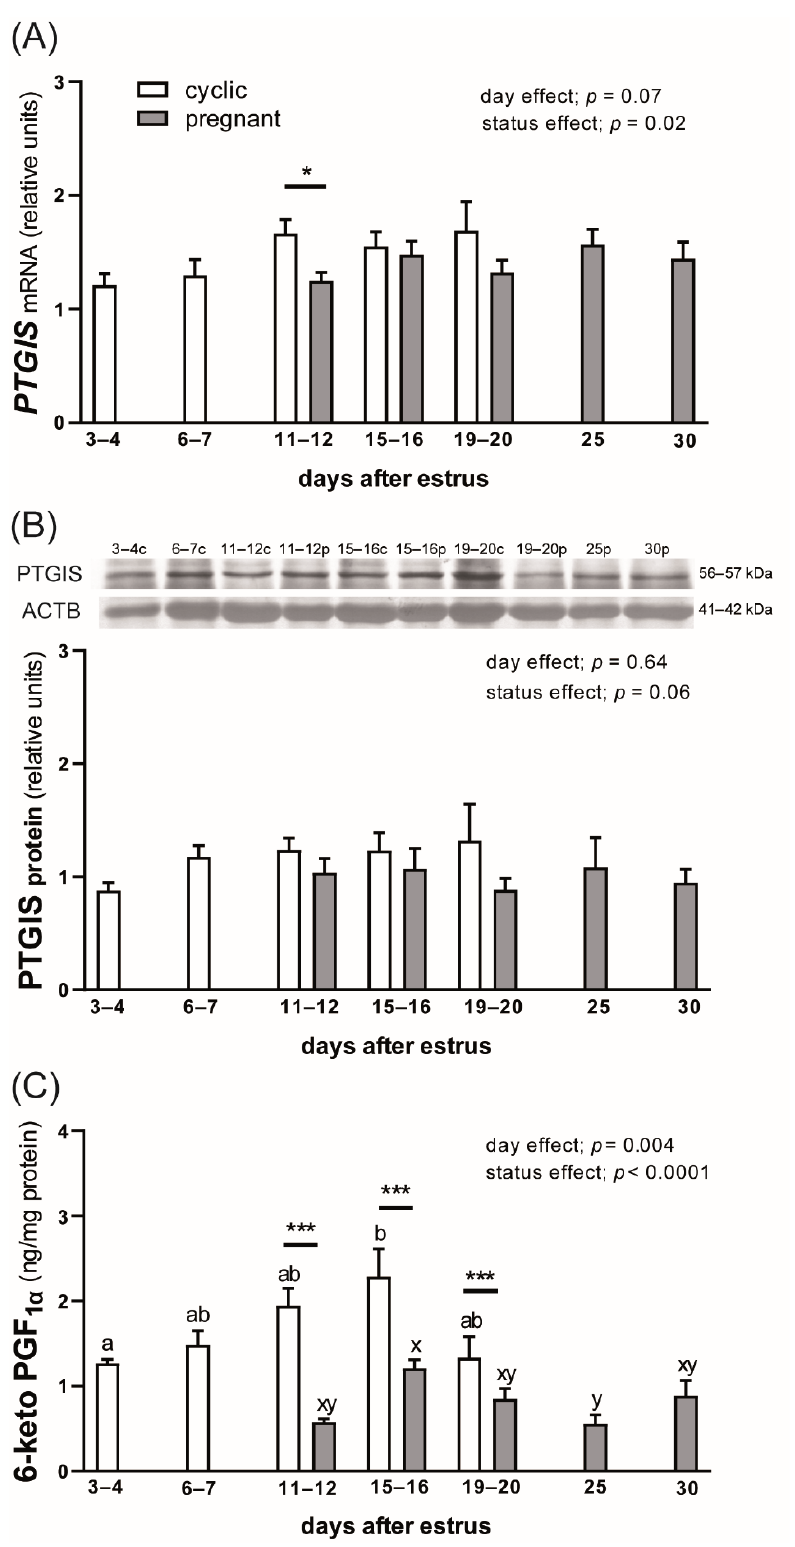
Figure 1. Expression of prostaglandin I2 (PGI2; prostacyclin) synthase (PTGIS) mRNA ( A ) and